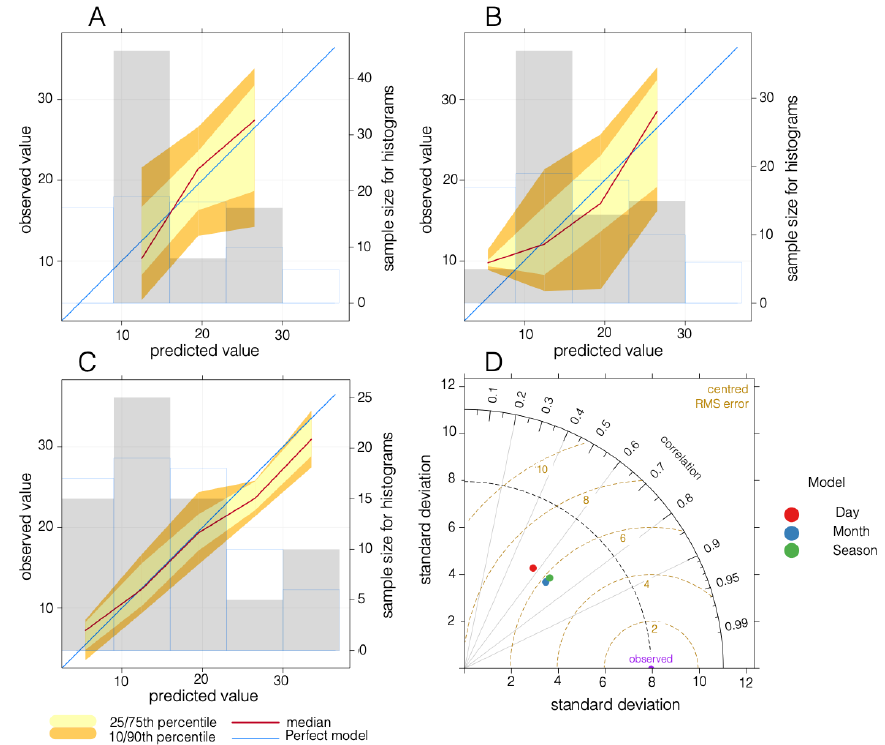
Figure 8. Conditional quantile plot to compare the three models (Season ( A ), Month ( B ) and Day ( C )) and their post-processed combinations with respect to the observed data in terms of distribution and Taylor diagram to compare the three models ( D ).